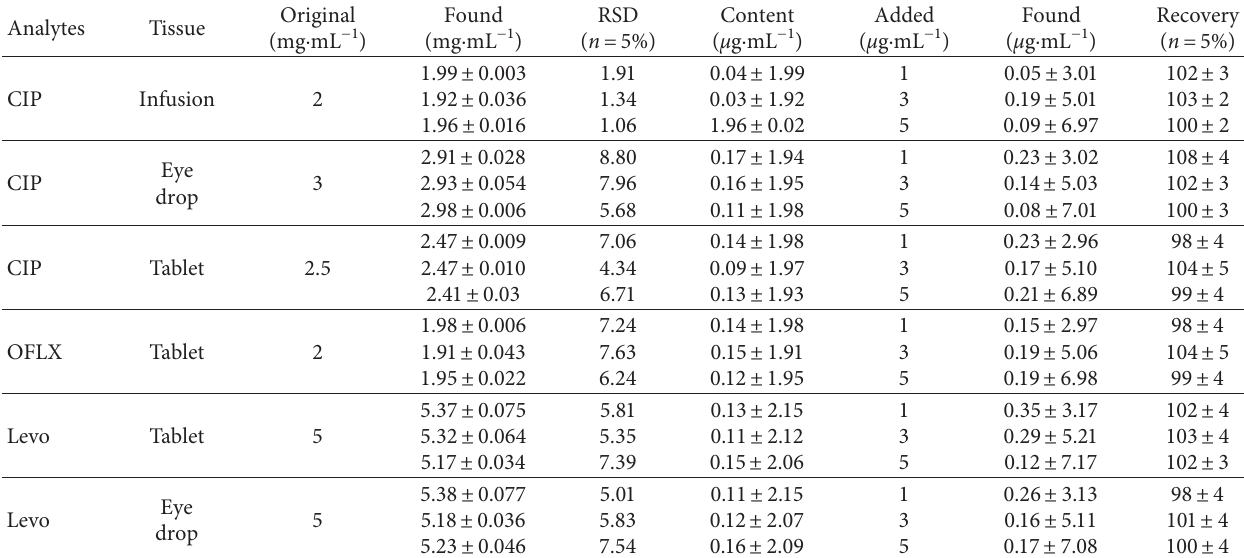
Table 4: Determination of ciprofloxacin, ofloxacin, and levofloxacin in pharmaceutical